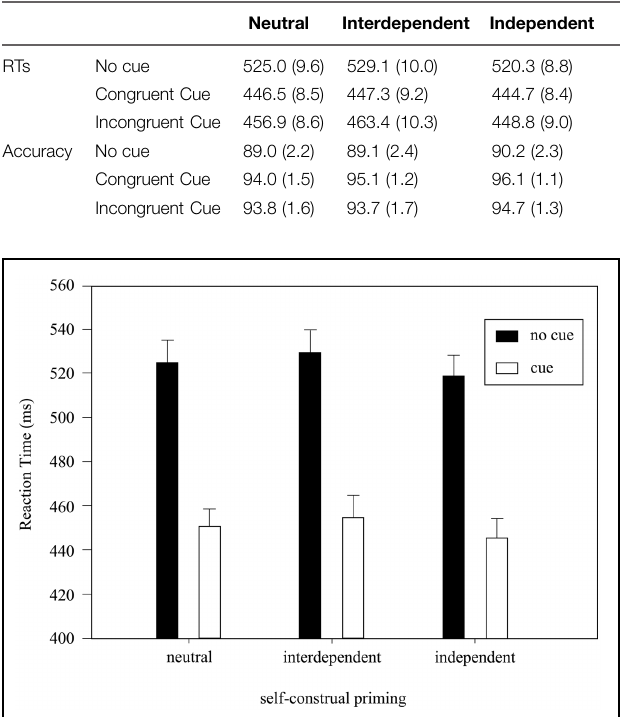
TABLE 1 | Mean reaction times (RTs) (ms) and response accuracy (%) (SEM).